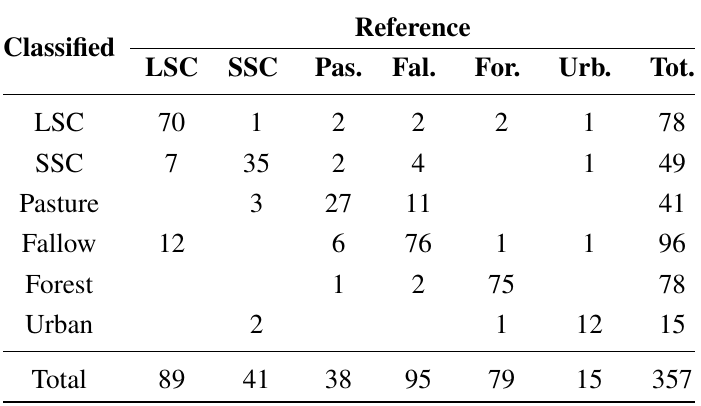
Table 5. Confusion matrix for the hierarchical classification of